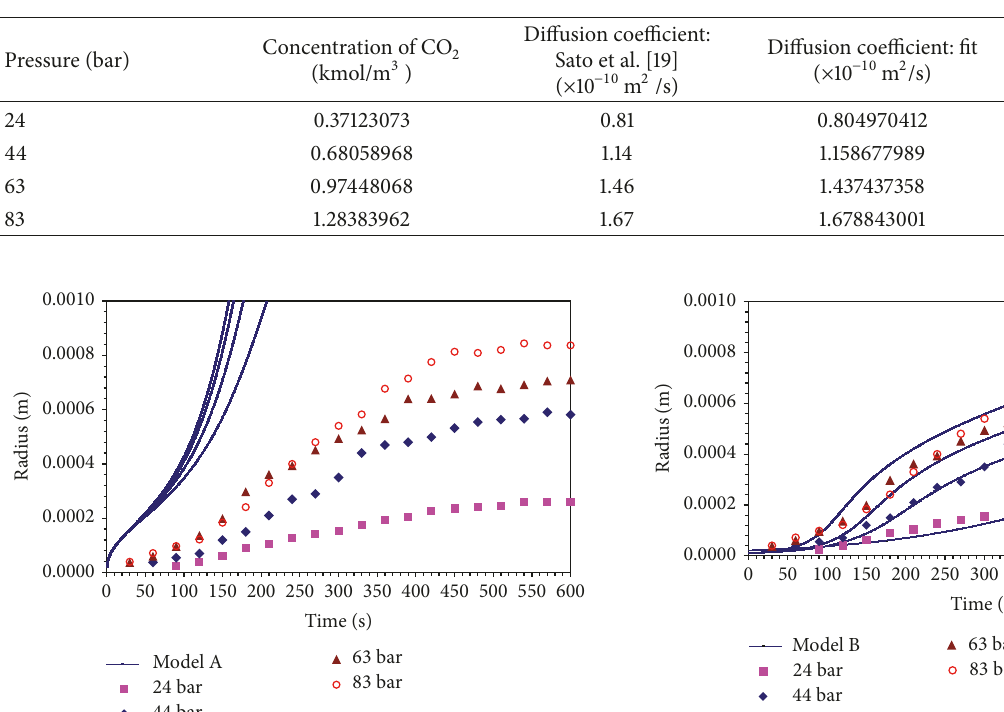
Table 3: Model C best fit diffusion coefficient at 100 ∘ C.